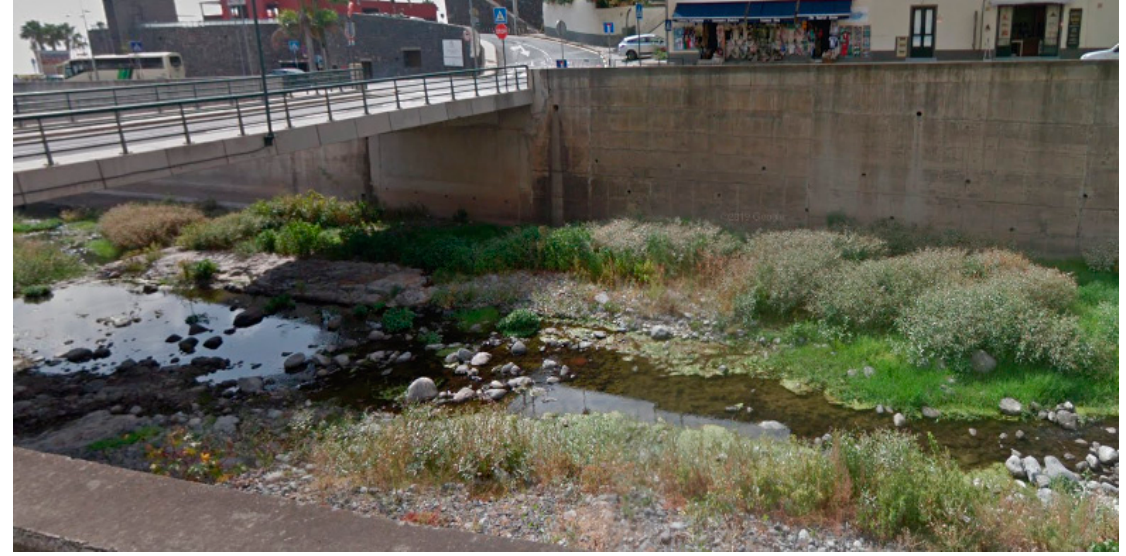
Figure 2. State of conservation of Ribeira Brava main watercourse river mouth.